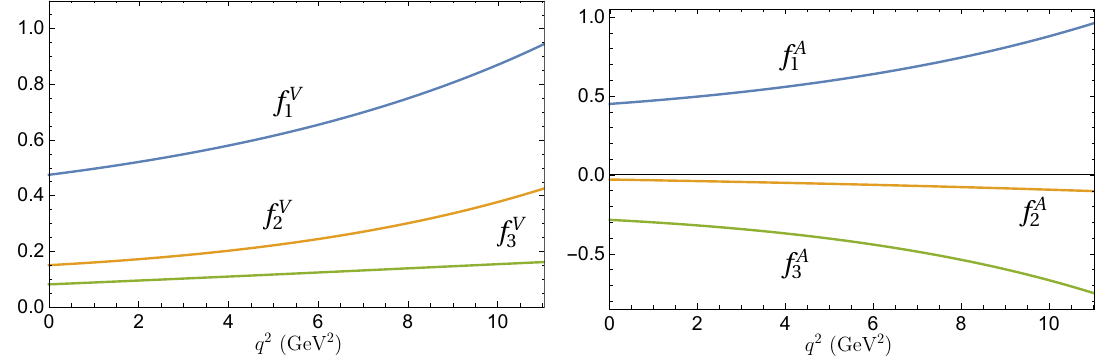
Ξ c transitions parameterizing vector ( left ) and axial vector →